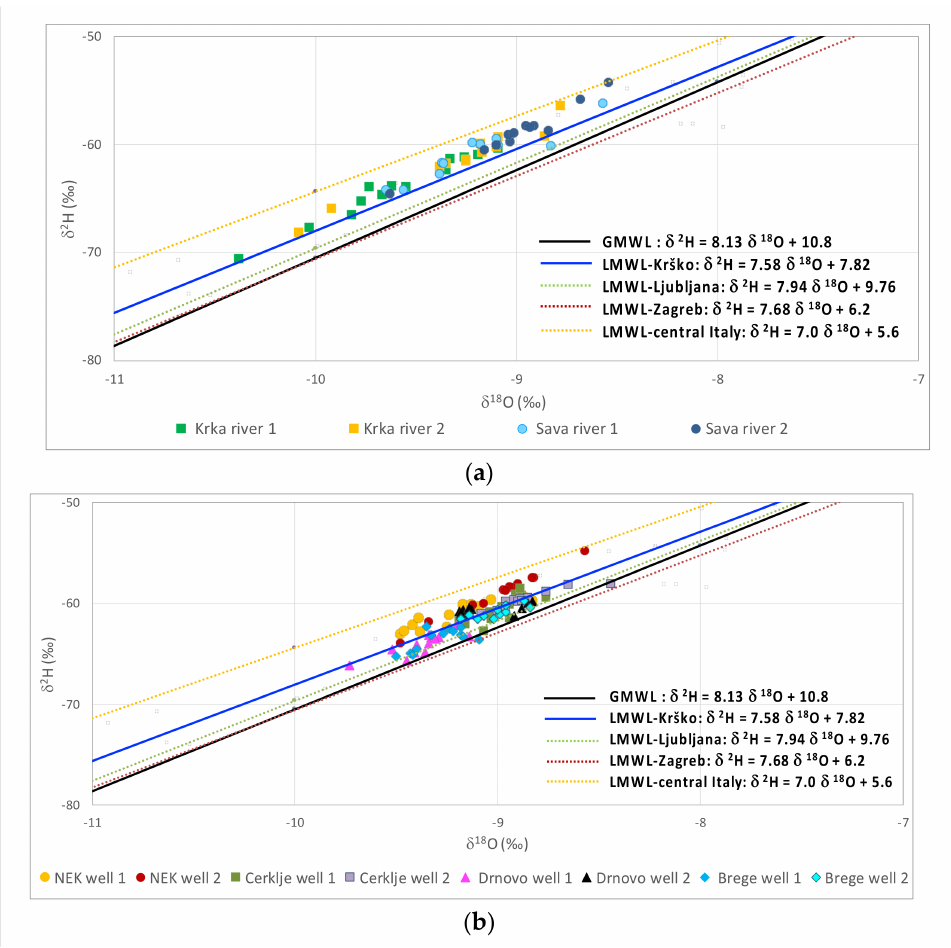
Figure 5. δ 18 O and δ 2 H in surface water ( a ) and groundwater ( b ) before (number 1 next to sample name) and after (number 2 next to sample name) the filling of the accumulation basin for the HPP